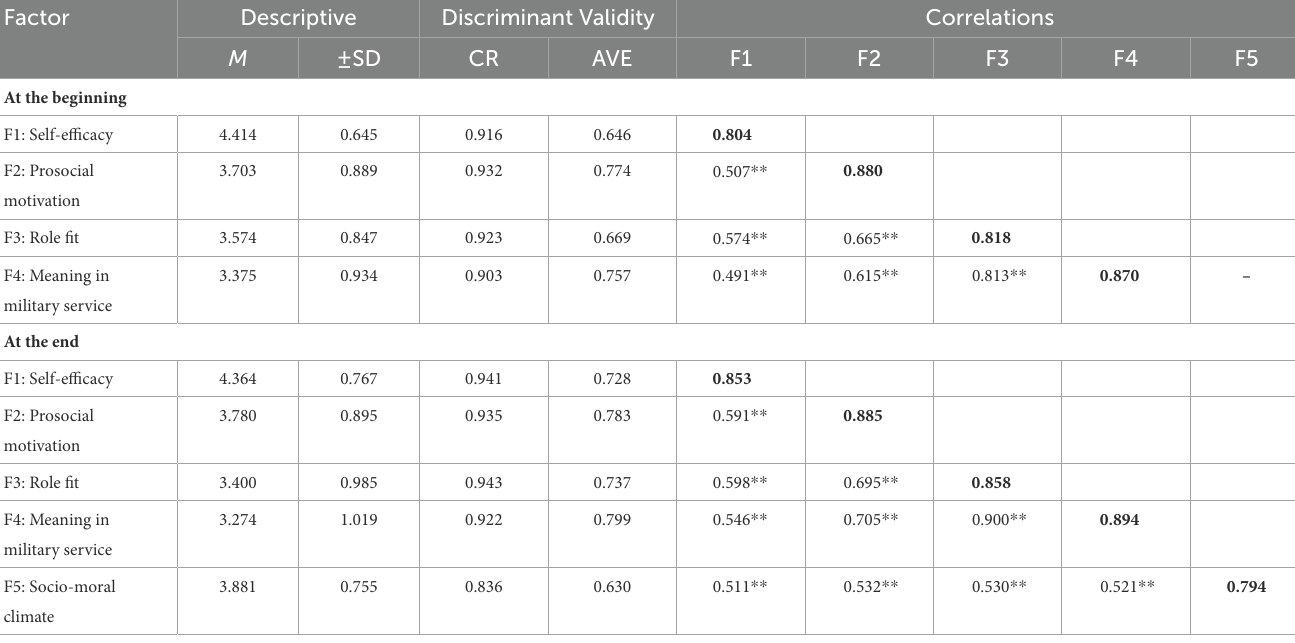
TABLE 1 The descriptive statistics, discriminant validity, and Pearson’s correlations between the study variables. Factor